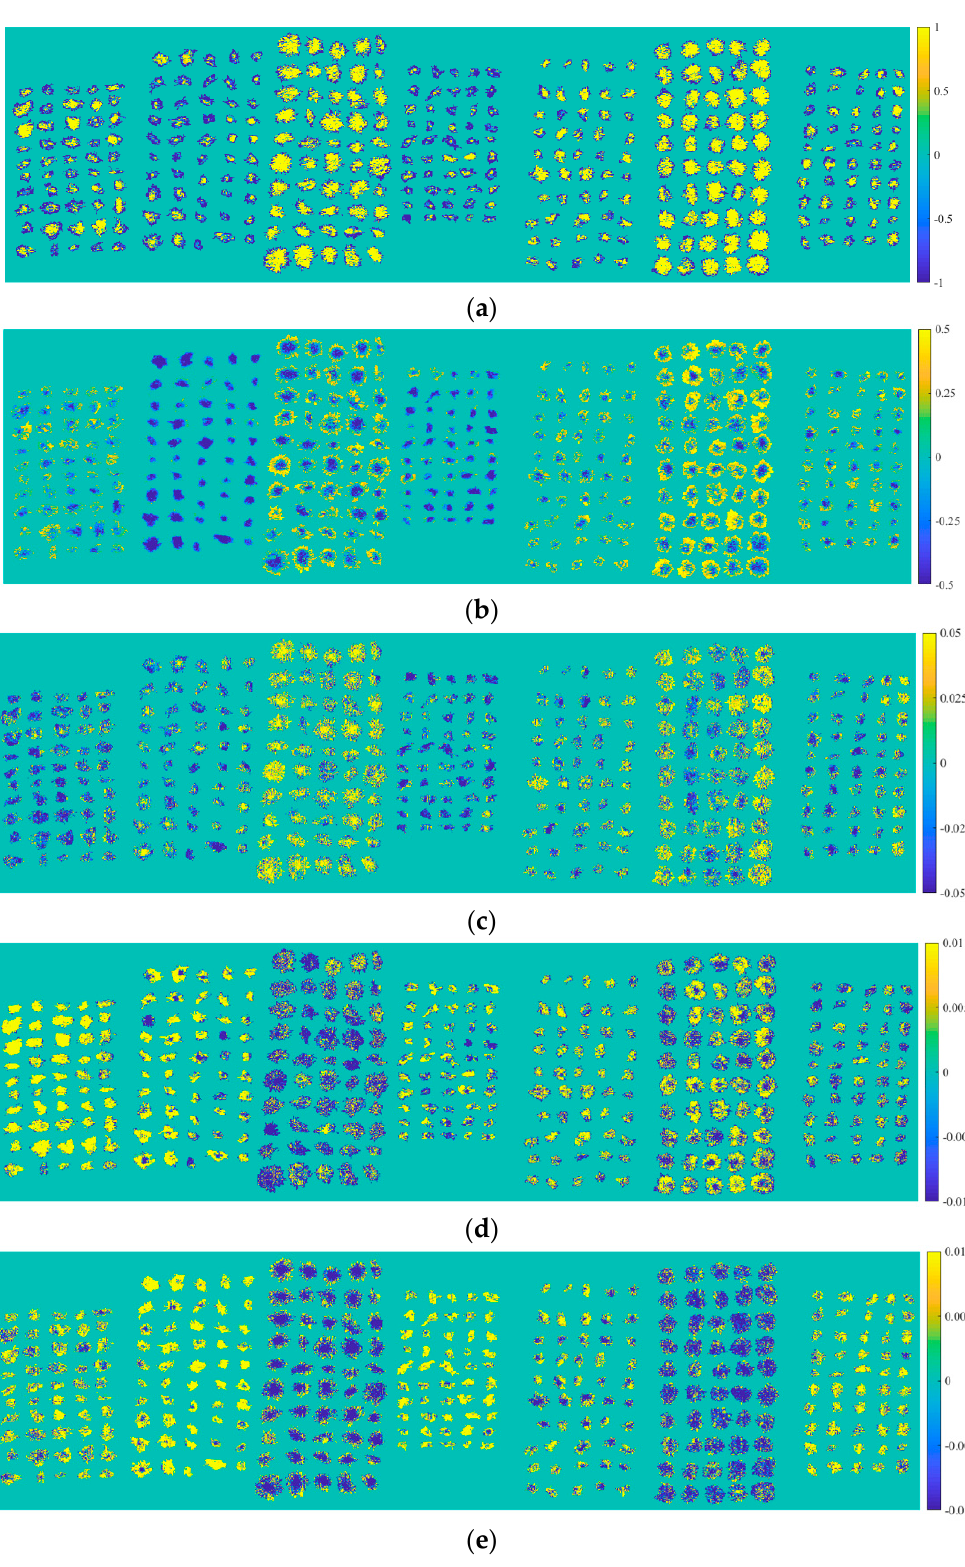
Figure 2. Score images of the first five PCs of seven Chrysanthemum varieties (from left to right: Boju, Chuju, Gongju, Hangbaiju, white Huaiju, yellow Huaiju, and Qiju): ( a ) PC1; ( b ) PC2; ( c ) PC3; ( d ) PC4; ( e ) PC5.